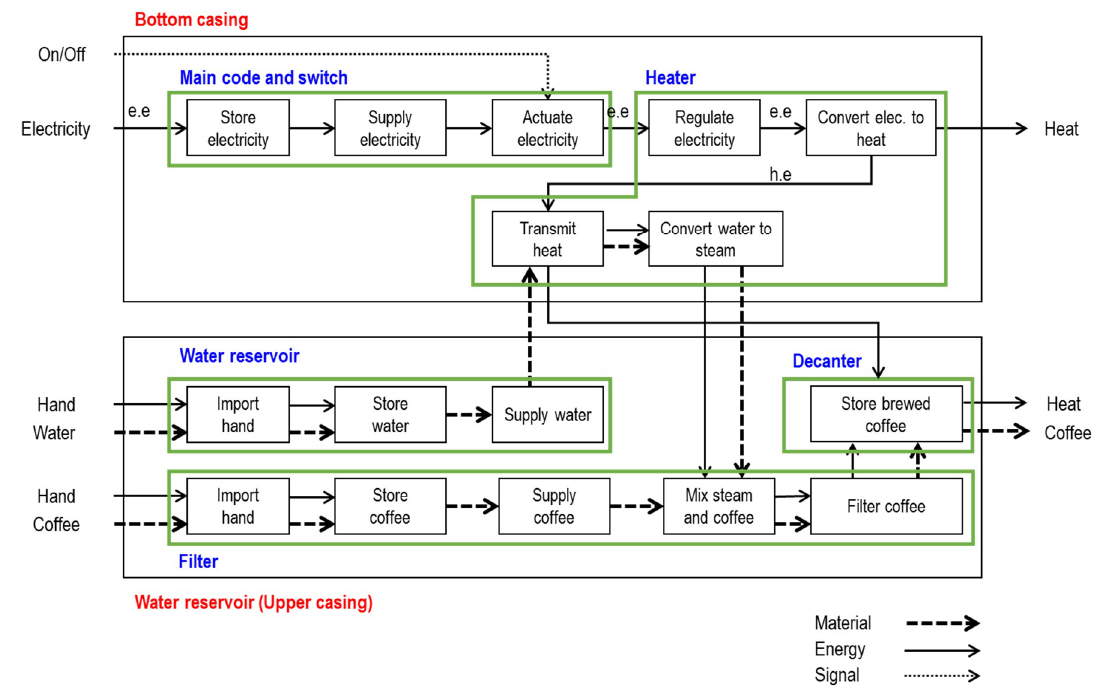
Figure 2. Functional diagram of the coffee maker.